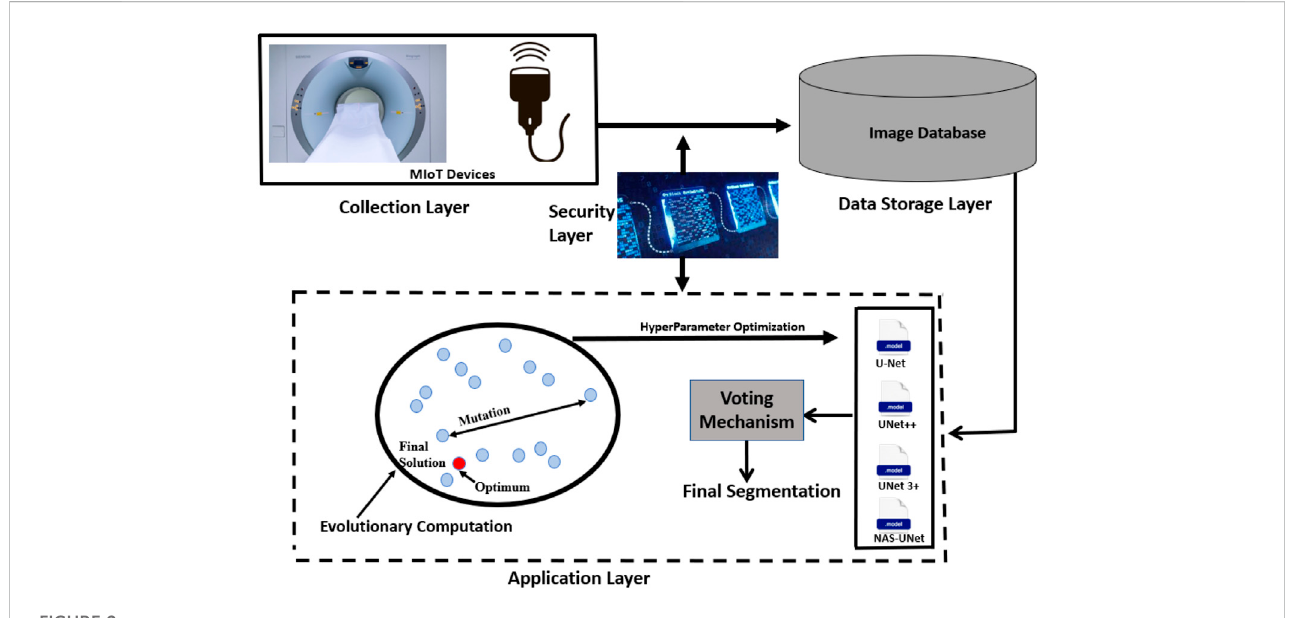
FIGURE 2 BIoMT-ISeg